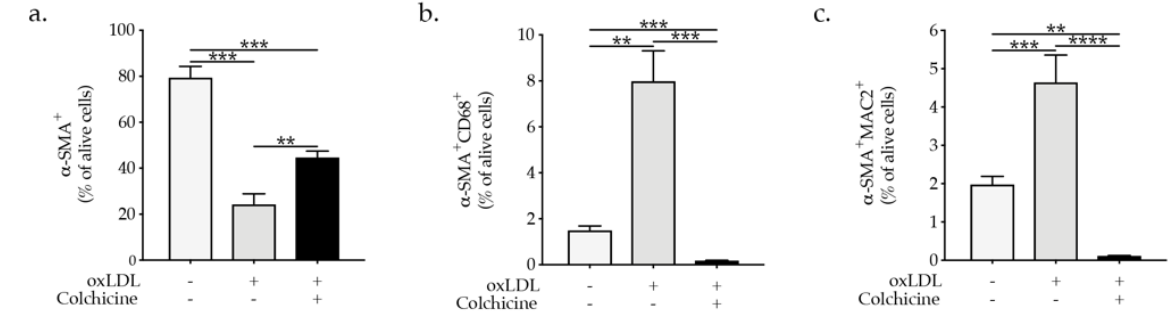
Figure 6. Graph bars represent the mean ± SEM of ( a ) α -SMA + , ( b ) α -SMA + CD68 + , and ( c ) α -SMA + MAC2 + expression in VSMCs upon colchicine and/or oxLDL treatment as indicated, with n = 5–6/group and ** p < 0.01, *** p < 0.001, **** p < 0.0001 one-way ANOVA.